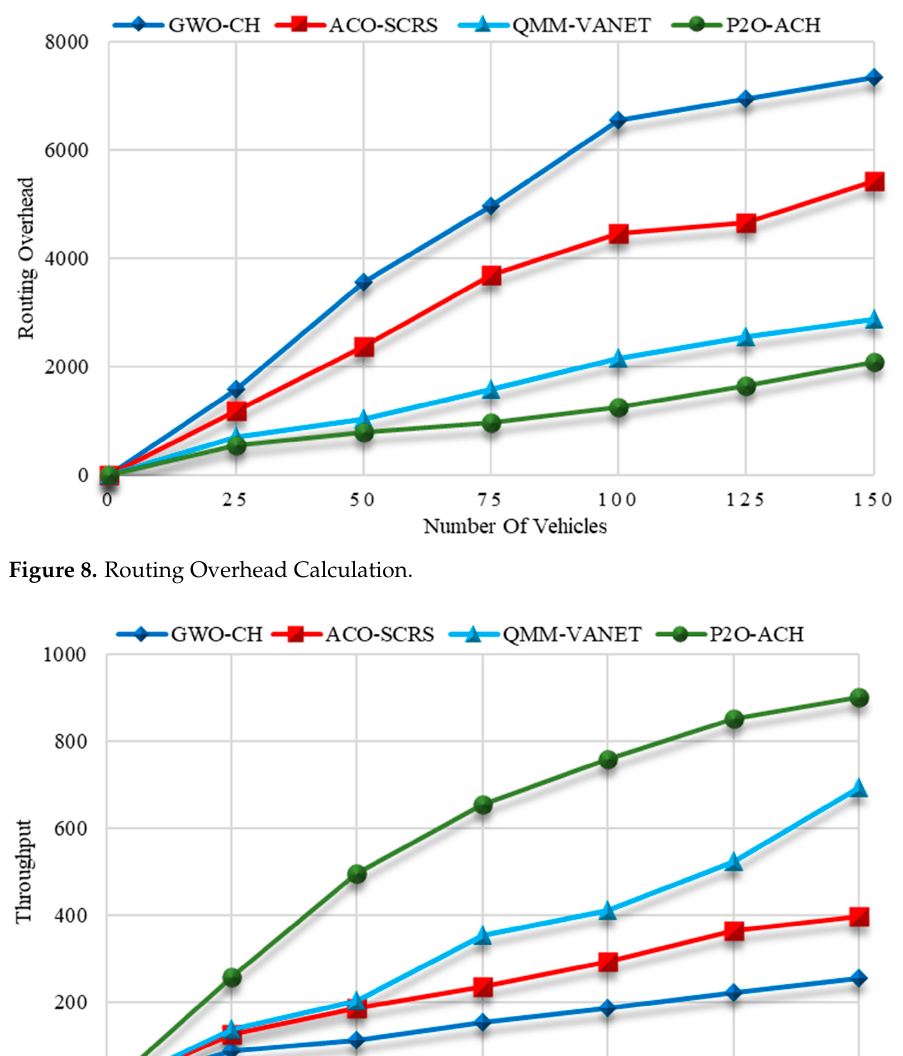
Figure 9. Network Throughput Calculation. Table 8. Performance Values of Routing Overhead and Throughput Calculation of the